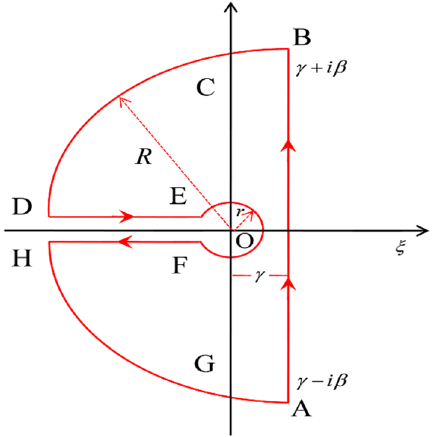
Γ . Figure 2. Bromwich–Hankel integration path Γ